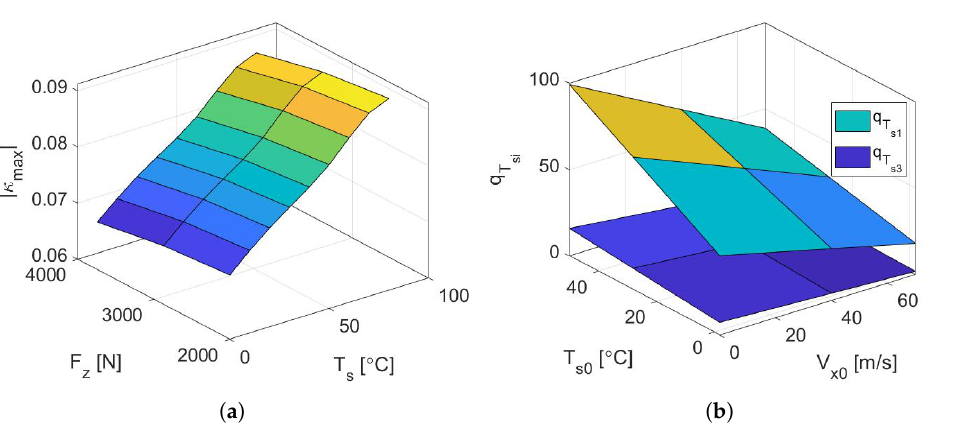
Figure 19. Variable reference as a function of T s and F z and variable weights on T si for ( κ & T s )- control. ( a ) Longitudinal slip reference for the controller— κ max ( F z , T s ) . ( b ) Full-car variable controller weights— q T and q T s 3 s 1